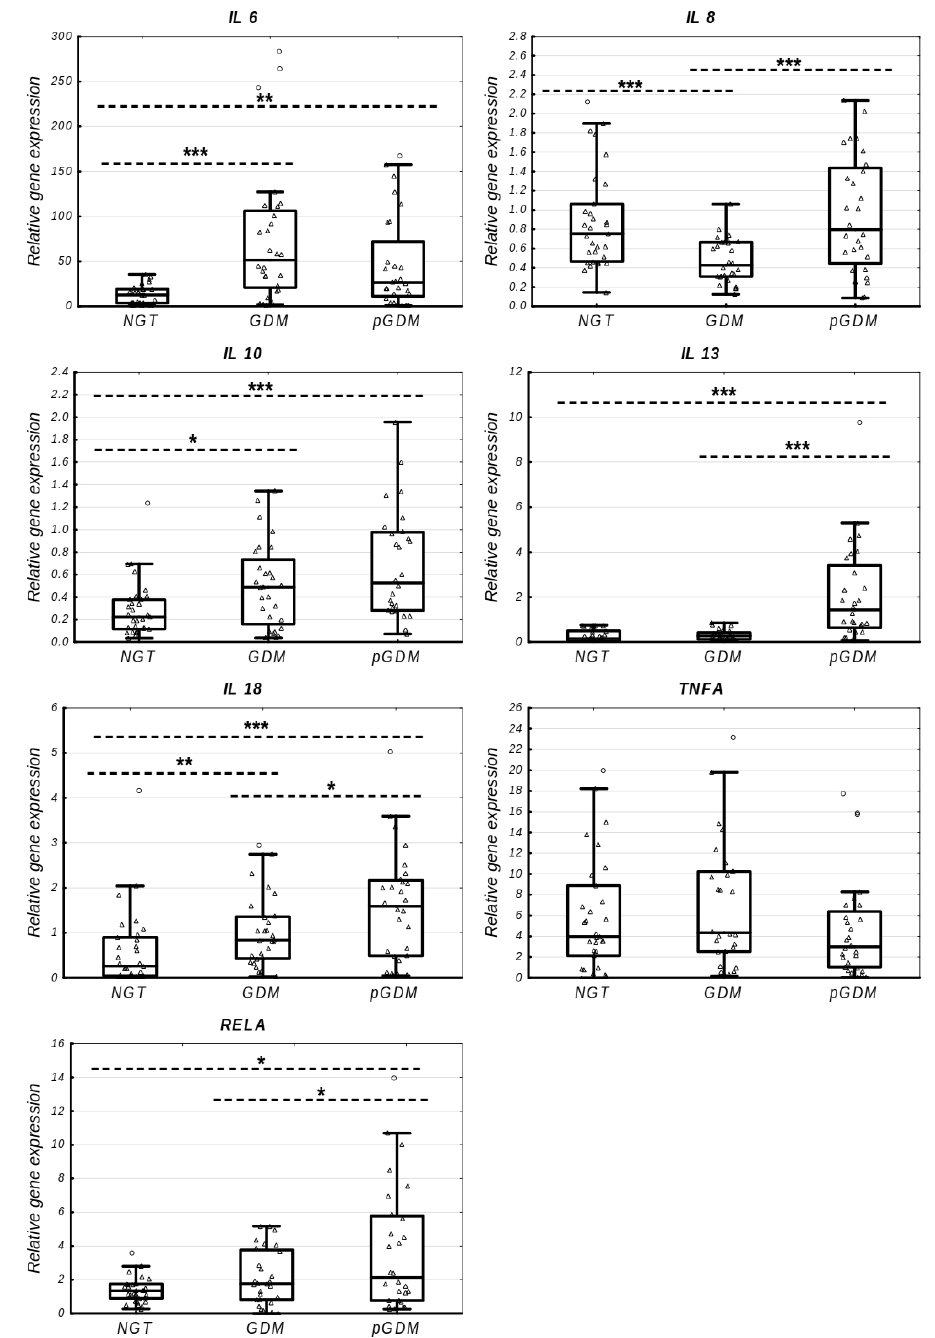
Figure 2. Comparison of the relative leukocyte mRNA expression (the ratio of the target gene relative to the reference gene ACTB) of all genes investigated between the NGT ( n = 31), GDM ( n = 28), and pGDM ( n = 28) groups. Data are expressed as median (indicated by horizontal bars) with interquartile range (indicated by boxes) and 1.5 interquartile ranges (indicated by Tukey whiskers). Raw data points are shown as triangles. Outliers are marked as circles. * p < 0.05, ** p < 0.01, *** p < 0.001 as assessed by the Mann–Whitney U test.